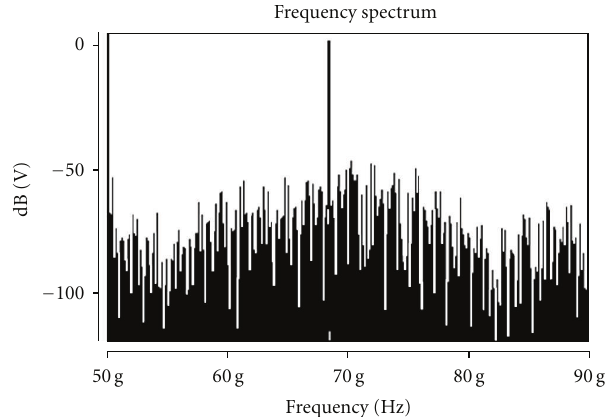
Figure 12: Frequency spectrum for the bu ff er cell oscillator output indicating a fundamental frequency of around 70GHz.